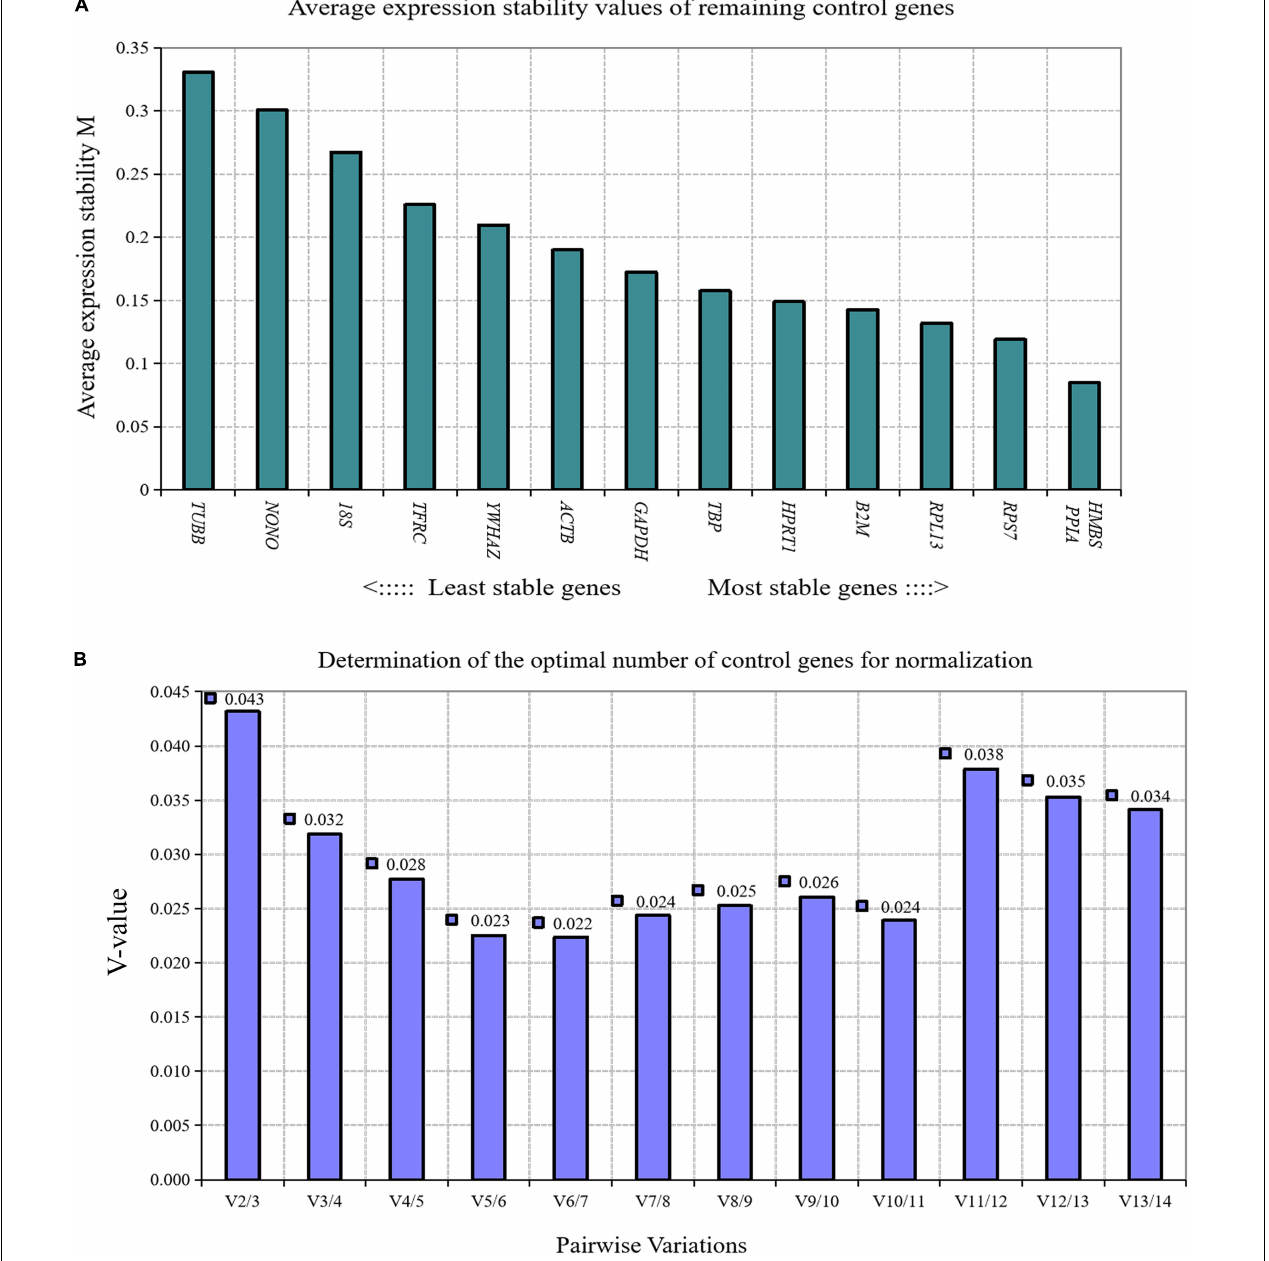
FIGURE 6 | GeNorm analysis of 14 reference genes during the proliferation of chicken primary preadipocytes. (A) Expression stability analysis. The most stably expressed genes have lower M values. HMBS and PPIA were the two best reference genes; (B) Pairwise variation analysis. Determination of the optimal number of reference genes required for normalization calculated by pairwise variation analysis between normalization factors NF n and NF n + 1 . According to geNorm algorithm, two reference genes were